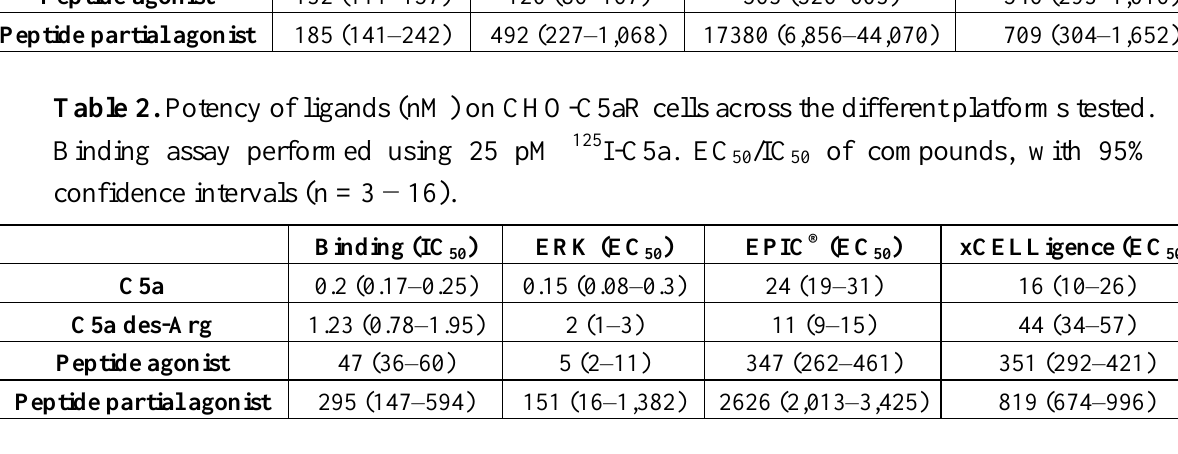
/IC of compounds, with 95% 50 50